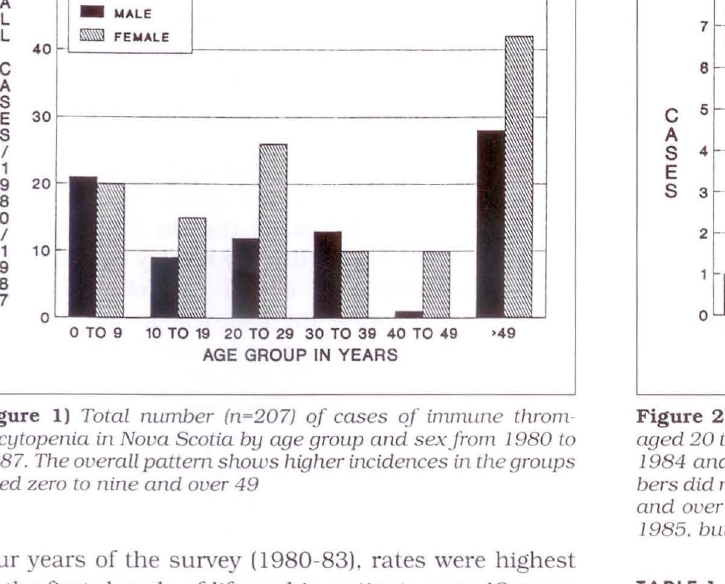
Rates of immune thrombocytopenia per 100,000